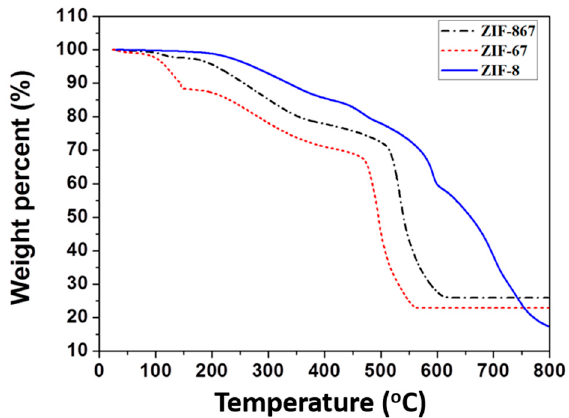
Figure 3. TGA curves of metal: ligand: TEA ratios of 1:16:16 for ZIF-8, ZIF-67, and ZIF-8-67 (Zn:Co = 0.5:0.5).